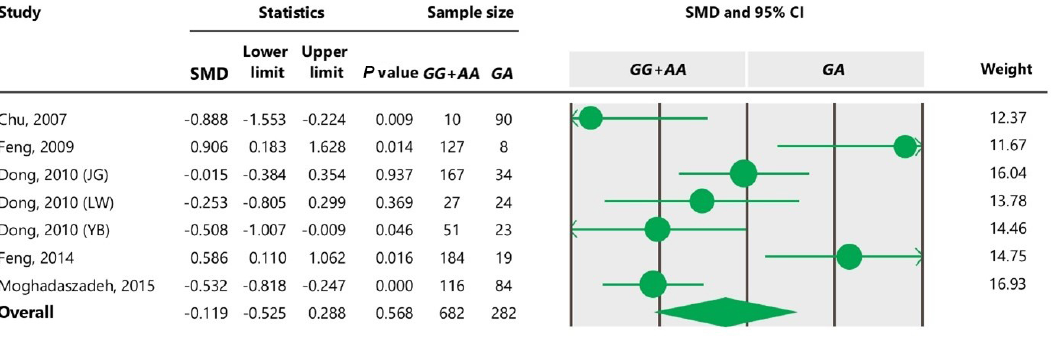
Table 8. Forest plots of sensitivity analysis under the additive model, with the Dong and Du (2010) Lubei White breed study removed (a)